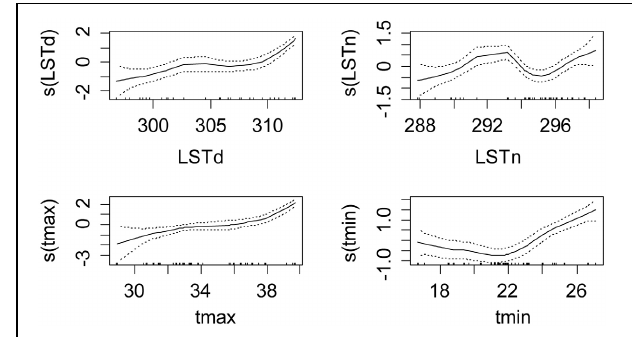
FIGURE 2 | Shape and amplitude of the relationships between tsetse infection rate and environmental variables. The values were estimated by a logistic regression model of cubic spline functions of environmental variables (LSTd and LSTn: MODIS Land Surface Temperature day and night in kelvins, tmin and tmax: minimum and maximum monthly averages of air temperature in ◦ C measured in meteorological stations). For each environmental variable y, s(y) represents the fit of the regression model and the uncertainty lines present the standard